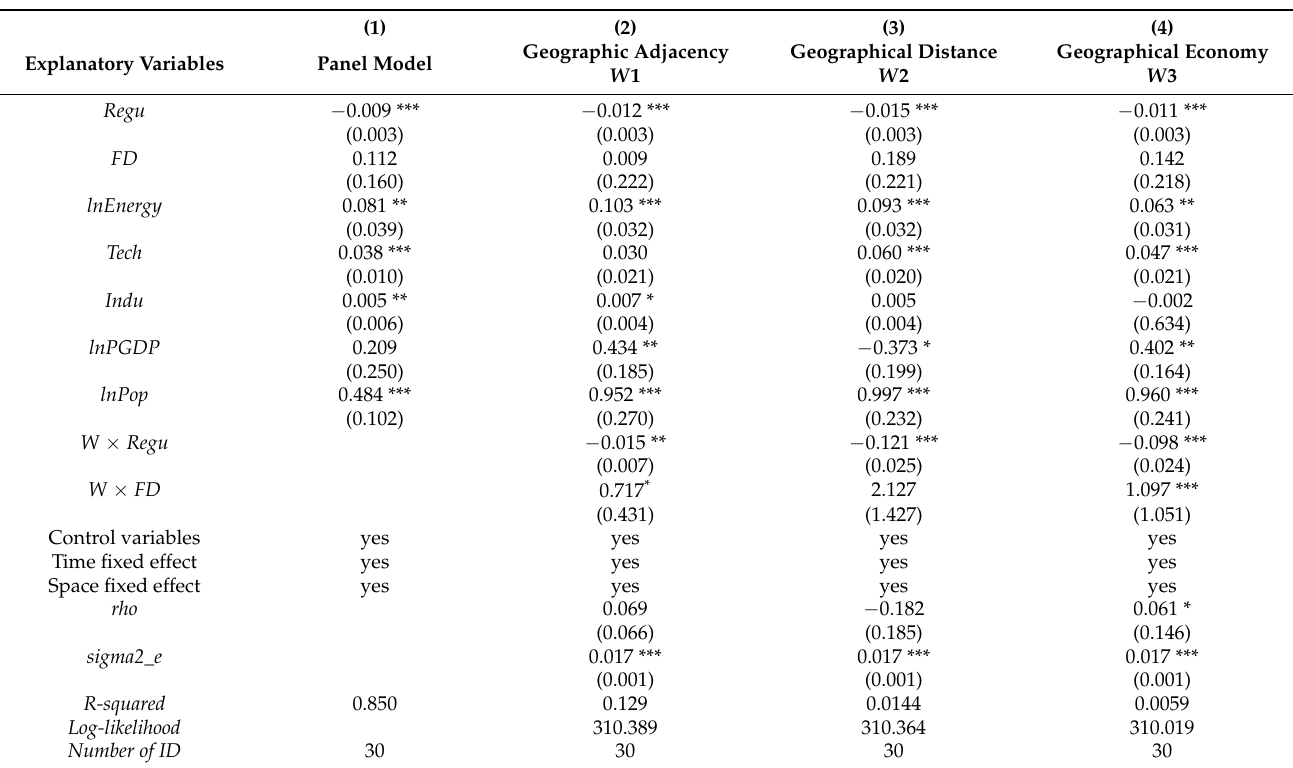
Table 9. Regression results of the effect of local government environmental regulation competition on carbon emissions (N =